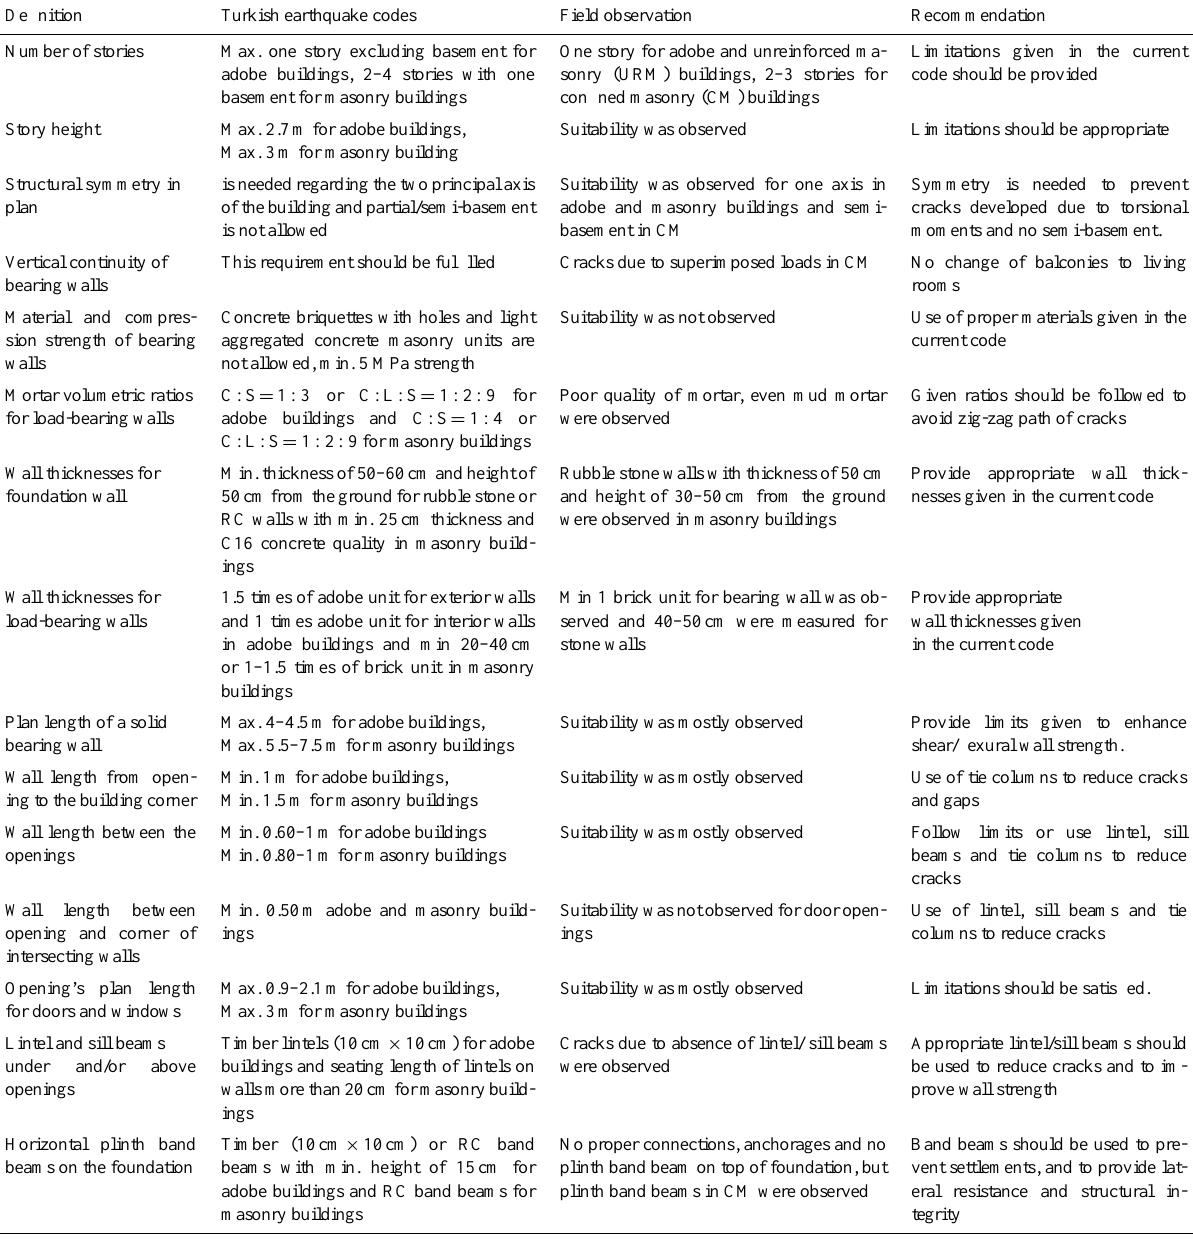
Table 1. Field observations and